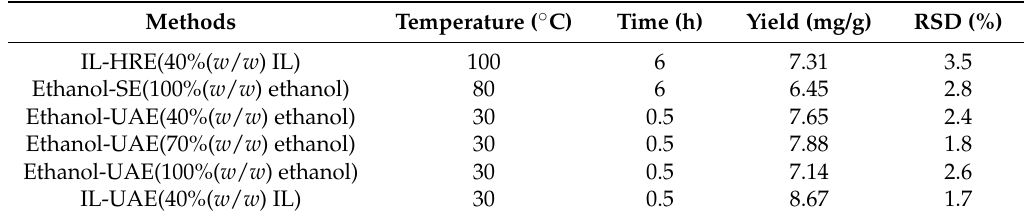
Table 3. Comparison of IL-UAE to conventional extraction methods.